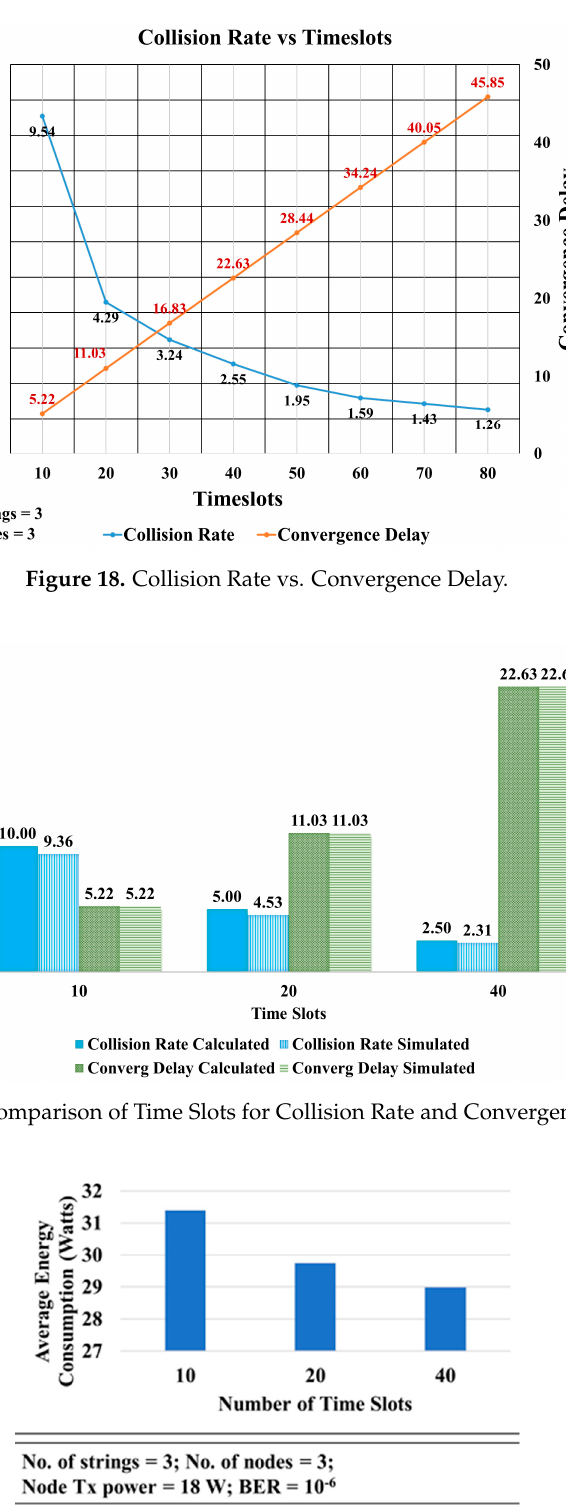
Figure 20. Energy Consumption vs. Number of Time Slots.